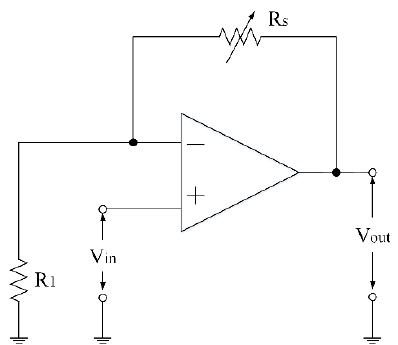
Figure 2. Non-inverting amplifier circuit for the ammonia gas sensor (AGS).